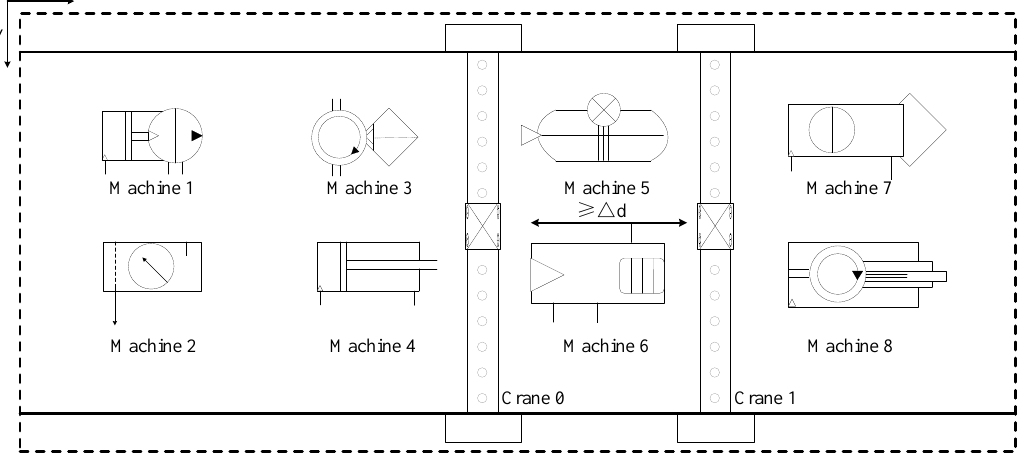
Figure 2. General workshop layout with crane transportation.